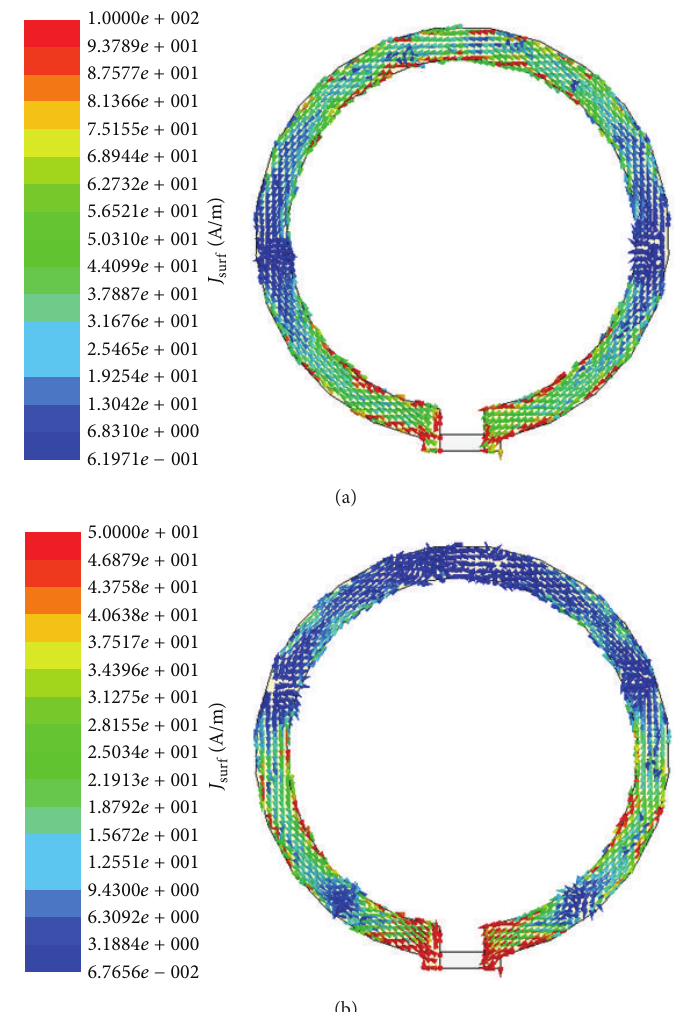
Figure 7: Simulated current distributions of the proposed antenna: (a) 2.4GHz: (b) 5.8